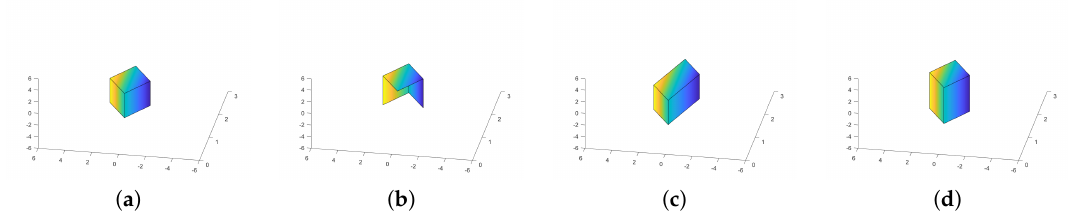
Figure 7. 3D shapes: we used four 3D shapes (cube, half cube and rectangular parallelepipeds) to represent the HLS extraction. ( a ) Cube; ( b ) Half cube; ( c ) Horizontal rectangular parallelepiped; ( d ) Vertical rectangular